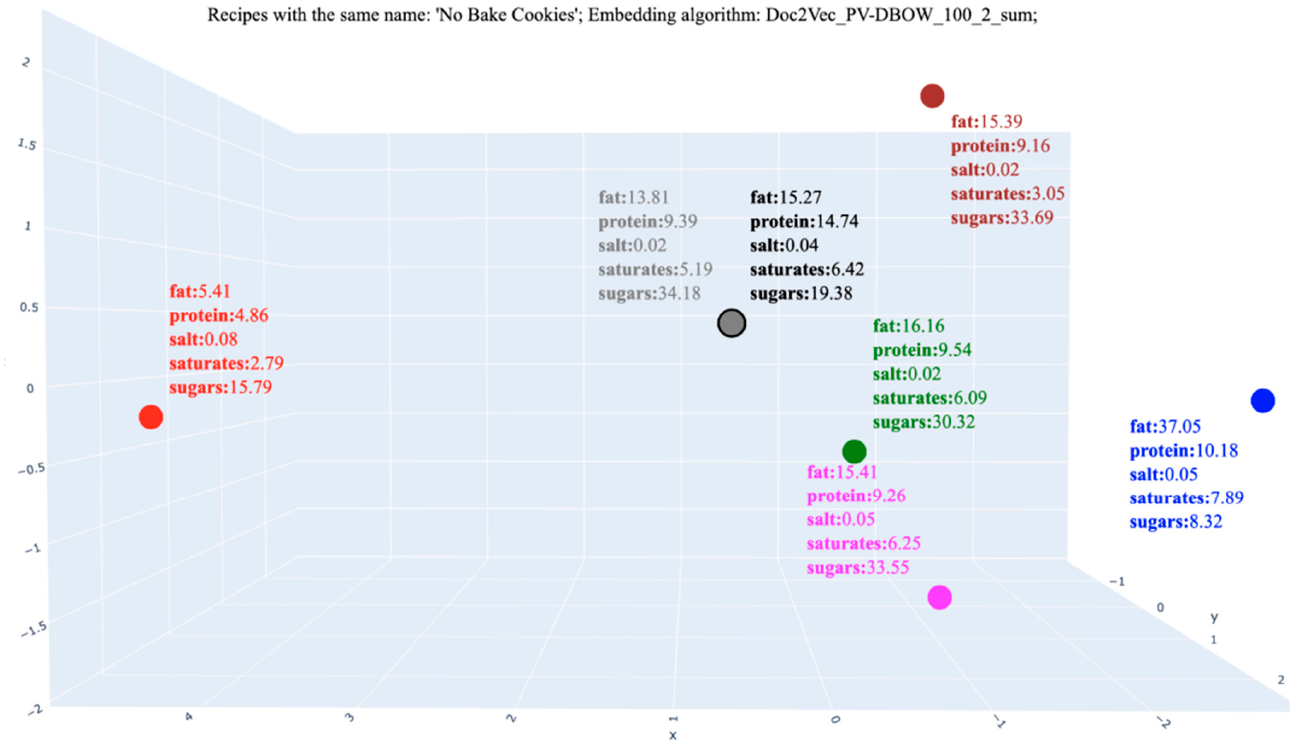
Figure 5. Visual representation of the vector representations without the domain-specific heuristic of a group of recipes with the same name.